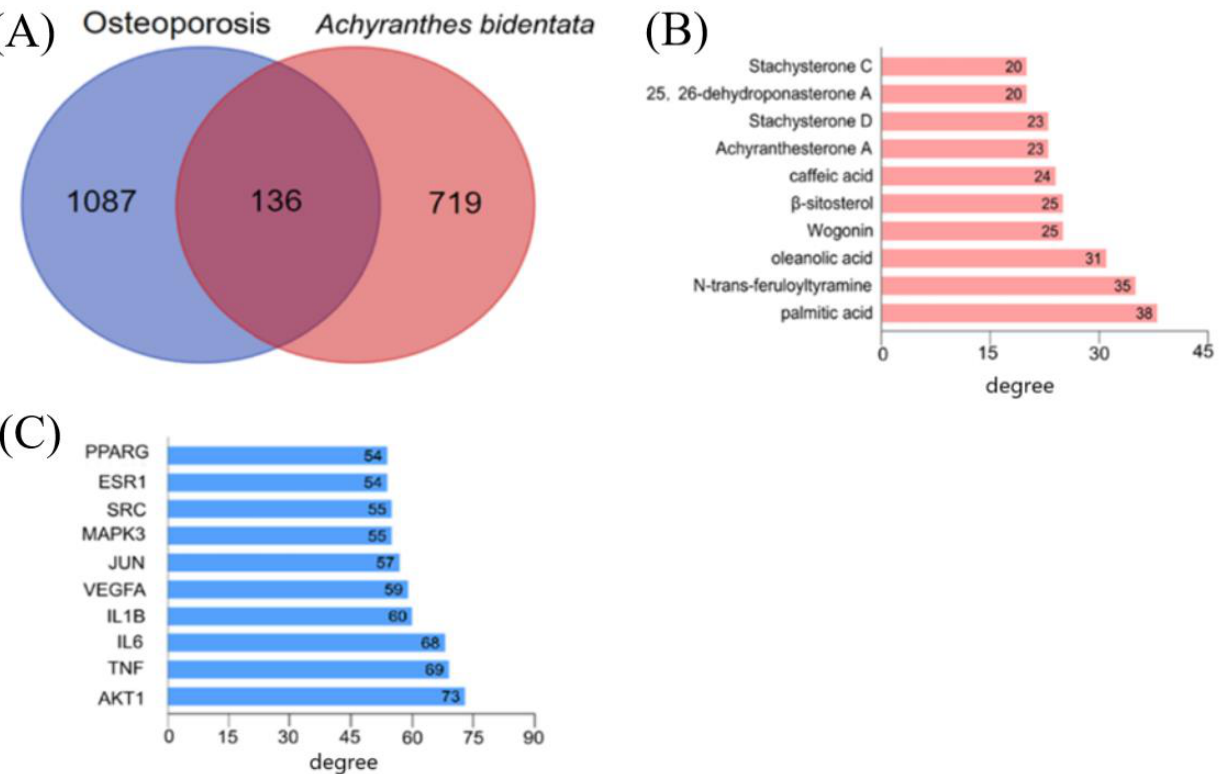
Figure 2. Network pharmacology analysis of crude and salt-processed AB on treating osteoporosis: ( A ) Venn plot, ( B ) top 10 compounds, ( C ) top 10 targets.